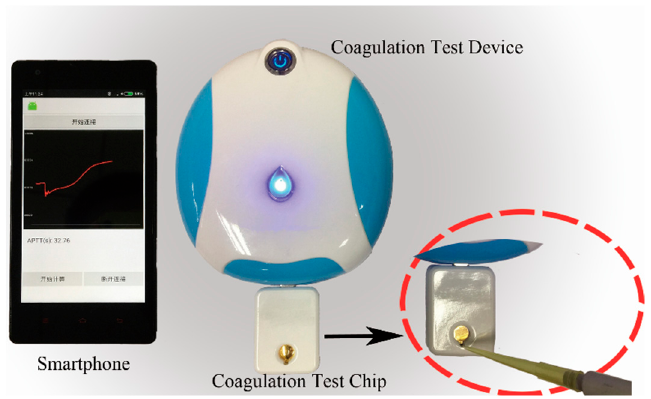
Figure 5. A photograph of the coagulation testing platform.